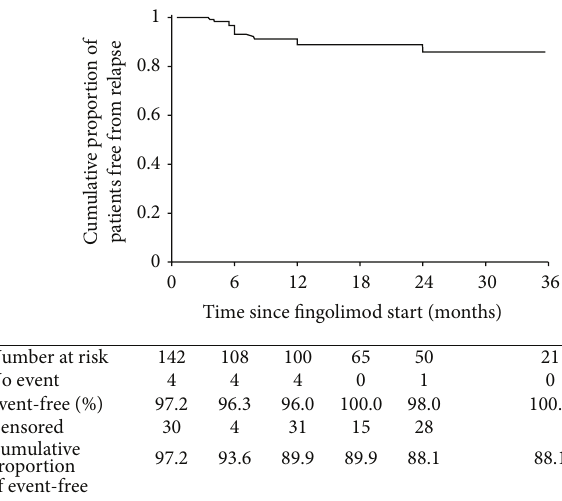
Figure 1: Kaplan-Meyer plot of cumulative proportion of patients remaining free from relapse over time from start of fingolimod therapy.